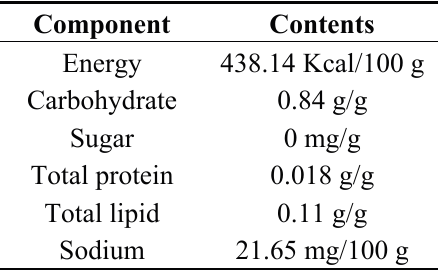
Table 1. Proximate analysis of